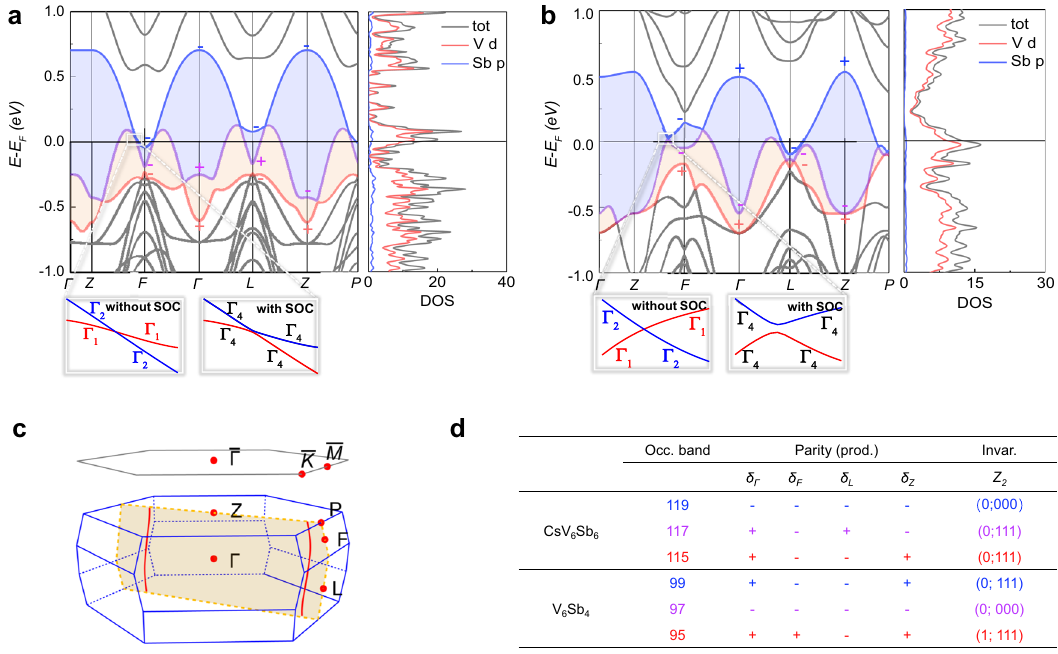
Fig. 2 Dirac nodal rings in the electronic structure of CsV 6 Sb 6 and V 6 Sb 4 . The band structures and projected density of states (DOS) were obtained from DFT calculations for a CsV 6 Sb 6 and b V 6 Sb 4 . The blue and yellow shaded areas highlight the topologically nontrivial bands near the Fermi level and the band gaps between them. The calculated parities are also shown for these bands at the TRIMs. The insets of panels a , b are zoom-ins of the Dirac band crossings along the Z-F direction without (left) and with (right) spin-orbit couplings. c The surface and bulk Brillouin zones of the rhombohedral A V 6 Sb 6 and V 6 Sb 4 . The cross-section marked by yellow color is the middle plane in which the high-symmetry paths are selected for the DFT calculations in a , b . The two red curves denote the position of type-II Dirac nodal lines in CsV 6 Sb 6 . d The parity at TRIMs and the Z 2 invariant for each band close to the Fermi level in CsV 6 Sb 6 and V 6 Sb 4